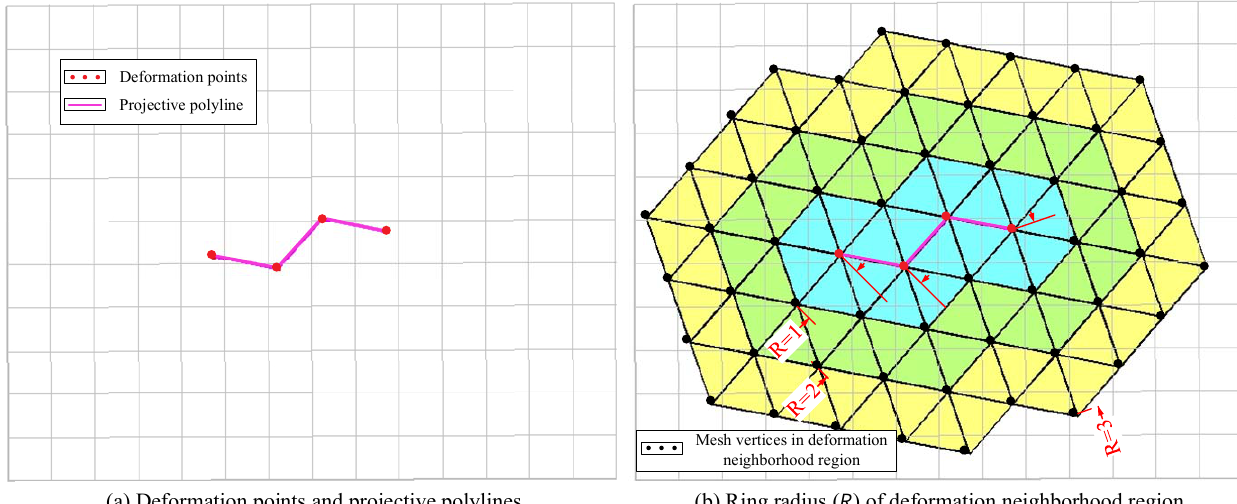
Figure 6. The determination of the initial deformation neighborhood region based on the ring radius of the deformation points. ( a ) Deformation points and projective polylines; ( b ) Ring radius ( R ) of deformation neighborhood region